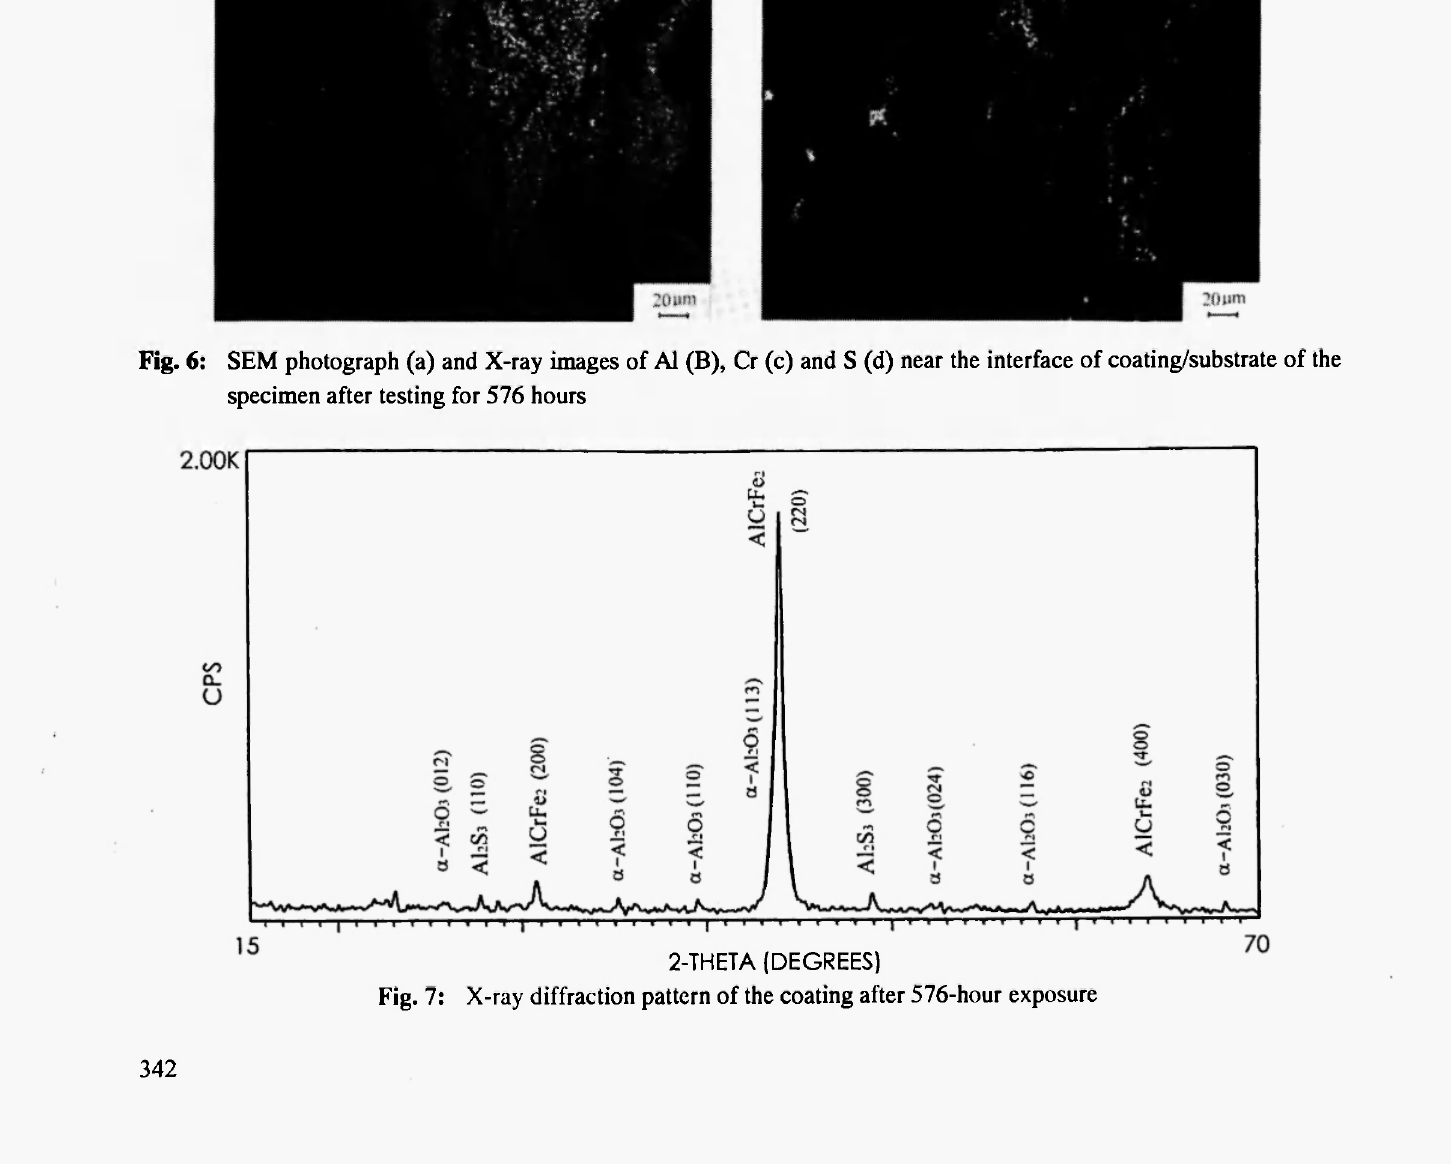
Fig. 7: X-ray diffraction pattern of the coating after 576-hour exposure